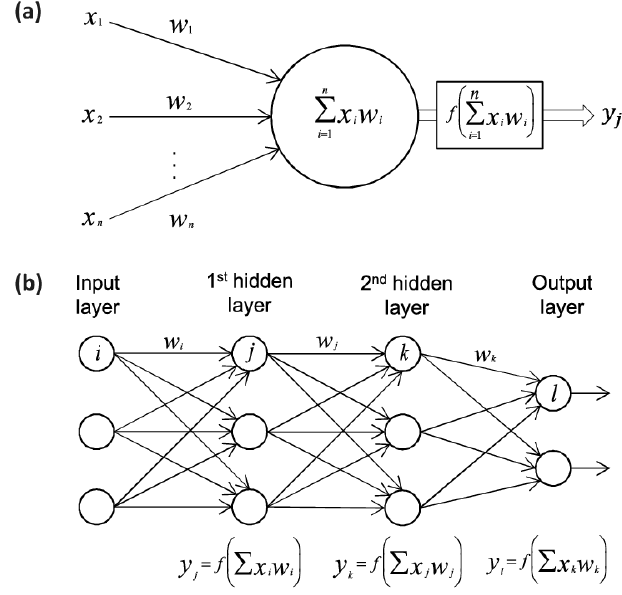
Fig. 2 Neural network related